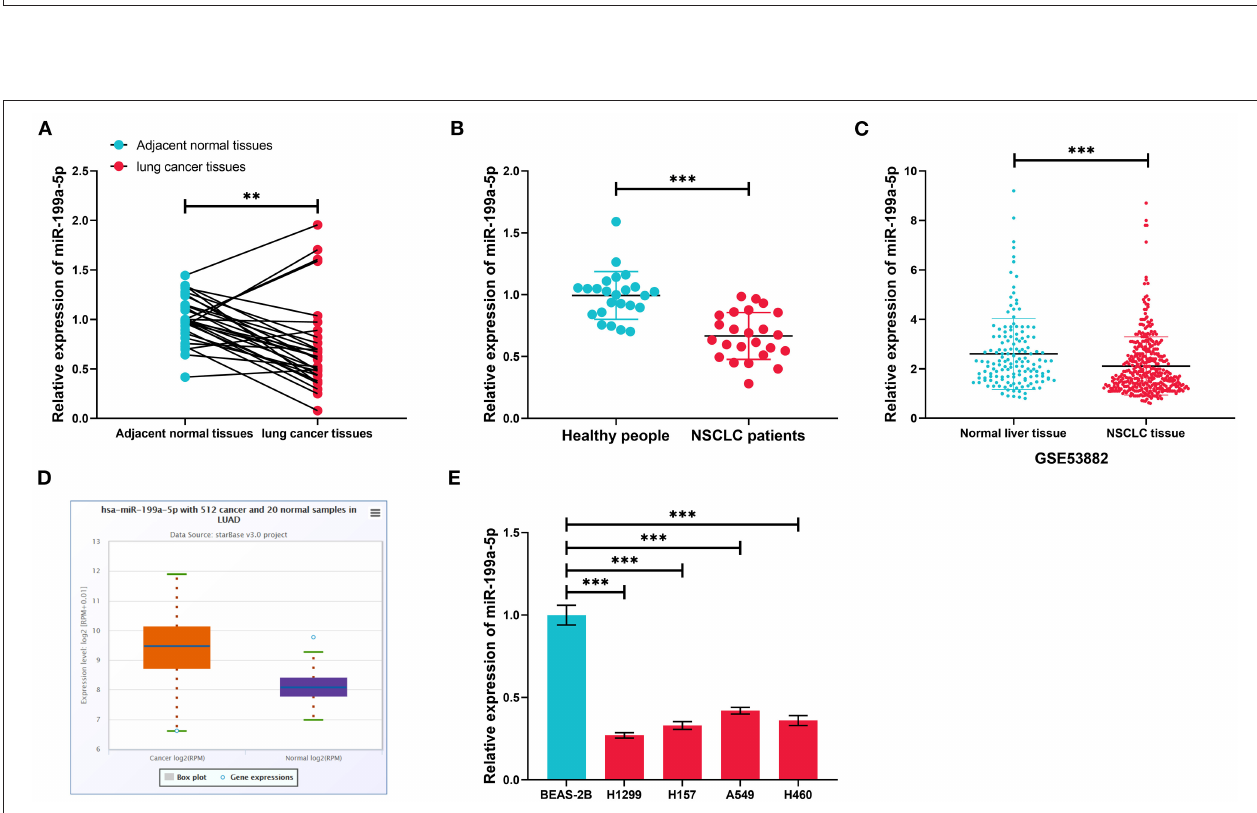
FIGURE 3 | The expression characteristics of miR-199a-5p in non-small cell lung cancer (NSCLC). (A) Expression of miR-199a-5p in 30 pairs of NSCLC tissues and adjacent normal lung tissues was detected by qRT-PCR. (B) Expression of miR-199a-5p in serum samples of NSCLC patients ( n = 30) and healthy subjects ( n = 30) was detected by qRT-PCR. (C) Expression of miR-199a-5p in 397 cases of NSCLC tissues and 151 cases of normal lung tissues. The data were derived from GSE53882. (D) Expression of miR-199a-5p in 512 cases of lung adenocarcinoma tissues and 20 cases of normal lung tissues in the ENCORI database. (E) Expression of miR-199a-5p in normal lung epithelial cells and NSCLC cell lines was detected by qRT-PCR. All of the experiments were performed in triplicate. ** p < 0.01 and *** p < 0.001, respectively.